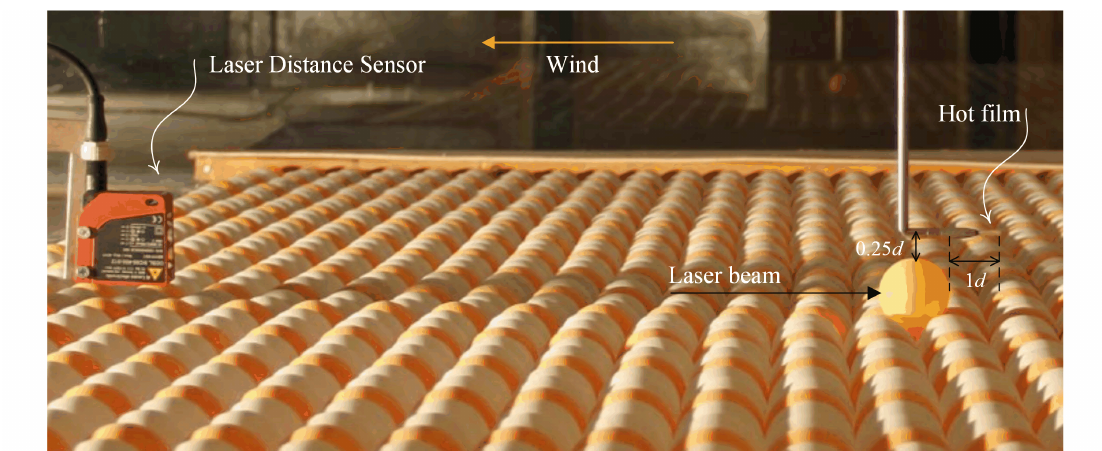
Figure 3. Photograph of experimental setup. A 0.1 mm resolution laser distance sensor (LDS, manufactured by Leuze Electronics, Owen, Germany) was used to track the motion of the target particle. A red laser beam with 655 nm wavelength launched by LDS shone at the center of the target particle. Once the particle began to rock along or against the wind direction, the corresponding displacement could be measured by the sensor. The measuring range of the sensor was set from the rest position of the target particle to the top of the downstream supporting particles, where the mobile particle would be considered to have been completely entrained. Calibration of the setup showed that the measured displacement of the target particle is a linear function of the signal intensity of the